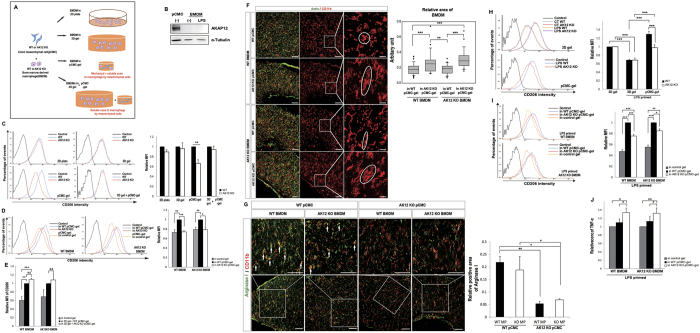
The difference of macrophage polarity between WT pCMC–gels and AKAP12 KO pCMC-gels.(A) Experimental design of collagen gel assay with pCMCs and BMDMs. (B) Immunoblots of AKAP12 and α-tubulin in lysate of WT pCMCs and BMDMs. (C) Relative CD206 intensity of WT (blue) and AKAP12KO (red) BMDMs in 2D plate, 3D gel, pCMC-gels and 3D gel with pCMC-gels. (n = 3, n = 6, n = 7 and n = 3, respectively). (D) Relative CD206 intensity of WT and AKAP12 KO BMDMs in control gel (orange), WT pCMC-gel (blue) and AKAP12 KO pCMC-gel (red). (n = 4 per group). (E) Relative CD206 intensity of WT or AKAP12 KO BMDMs in gels, WT pCMC-gels or AKAP12 KO pCMC-gels measured by FACS (n = 3 per group). (F) Representative confocal imaging of WT or AKAP12 KO BMDMs in WT or AKAP12 KO pCMC-gels. Representative macrophages are magnified. Bars: 100 μm. Box plots of relative area of WT or AKAP12 KO BMDMs in WT or AKAP12 KO pCMC-gels. At least 28 macrophages were selected per group. (G) Immunostaining for arginase I and CD11b of WT or AKAP12 KO BMDMs in WT or AKAP12 KO pCMC-gels. Bars: 100 μm. Relative Arginase I positive area of remodeled collagen gels was measured by Image J. (n = 3 per all group). (H) Relative CD206 intensity of WT (blue in upper plots) or AKAP12 KO (red in upper plots) BMDMs in gel or LPS primed WT (orange in upper plots) or AKAP12 KO (purple in upper plots) BMDMs in gel and LPS primed WT (blue in lower plots) or AKAP12 KO (red in lower plots) BMDMs in pCMC-gels. (n = 3 per group). (I) Relative CD206 intensity of LPS primed WT or AKAP12 KO BMDMs in control gel (orange), WT pCMC-gel (blue) and AKAP12 KO pCMC-gel (red). (n = 3 per group). (J) Relative expressions of TNF-α in media of WT or AKAP12 KO BMDMs in control gels, WT pCMC-gels or AKAP12KO pCMC-gels are assessed by ELISA (n = 3 per group). All panels, FACS plots of CD206 are representative. CD206-negative controls are shown in black. CD206 fluorescence intensities of macrophages are relative value. P# < 10−5, P*** < 10−3, P** < 10−2, P* < 0.05. Error bars, s.e.m.